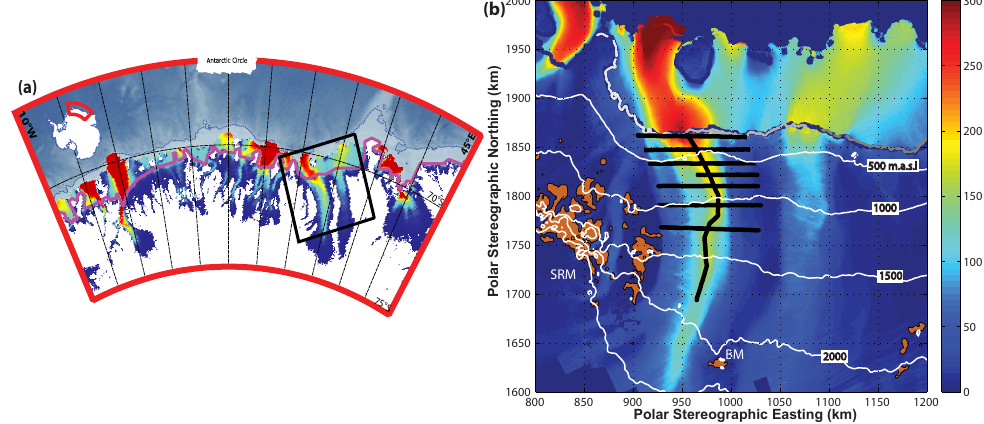
Fig. 1. Overview map of West Ragnhild Glacier, Dronning Maud Land, East Antarctica. (a) Dronning Maud Land. Ice flow speed is shown on the same scale as for panel (b) (but white when < 15myr − 1 ; Rignot et al., 2011a). The grounding line is shown in purple (Bindschadler et al. , 2011). Rock outcrops are shown in brown (SCAR, 2012). The square shows the 400km × 400km area covered by the map on panel (b) . The inset shows the coverage of panel (a) . (b) West Ragnhild Glacier. Background colour shows the surface flow speed derived from satellite interferometry and speckle tracking. Contours show surface elevations at 500m interval (Bamber et al., 2009). From west to east, the grounding line is defined on the basis of a pair of PALSAR images taken in 2007 (light grey) and two pairs of RADARSAT (middle grey and dark grey) taken in 2000 (Rignot et al., 2011b). Black lines are the longitudinal and transverse radar profiles. Rock outcrops as in (a) . SRM and BM stand for Sør Rondane Mountains and Belgica Mountains,